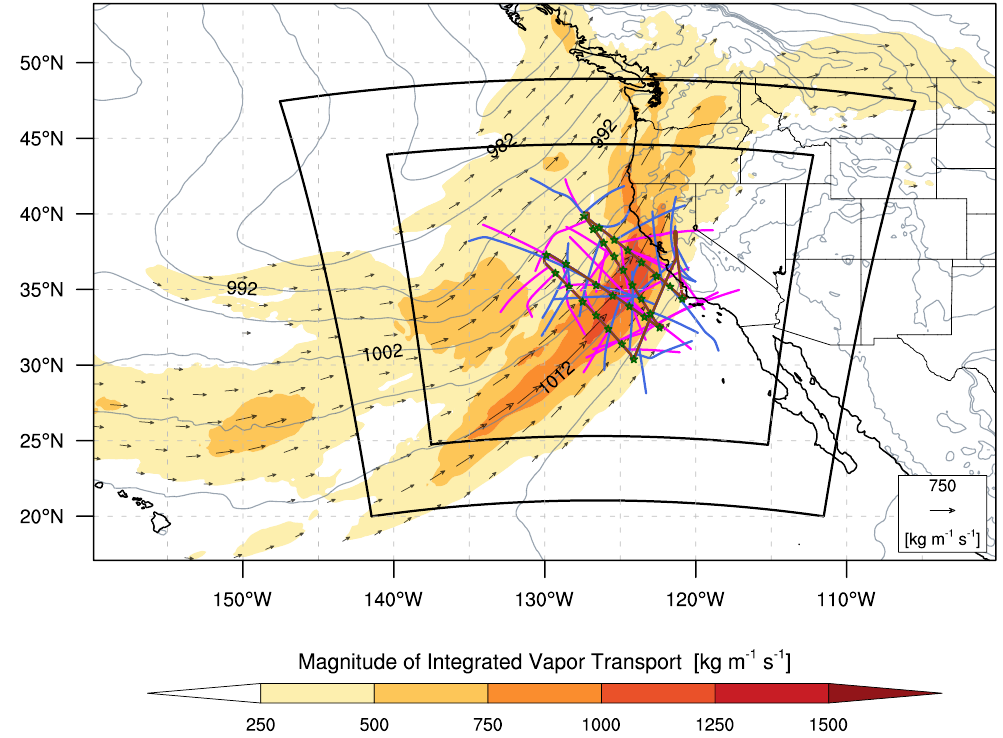
Figure 2. Integrated vapor transport (shaded and vectors, kg m − 1 s − 1 ) and mean sea level pressure (gray contours, hPa) from the ECMWF operational analysis valid at 18:00 UTC 6 February 2015. The flight path on 6–7 February 2015 (brown curve) is overlain with the location of dropsondes (dark green stars). The boundaries of the two mesoscale model grids (black rectangles) are shown. Pink lines connect the tangent point locations for an individual GPS satellite occultation profile, and blue lines indicate GLONASS occultations. The tangent points drift horizontally away from the flight path as the elevation angle of the GNSS satellite